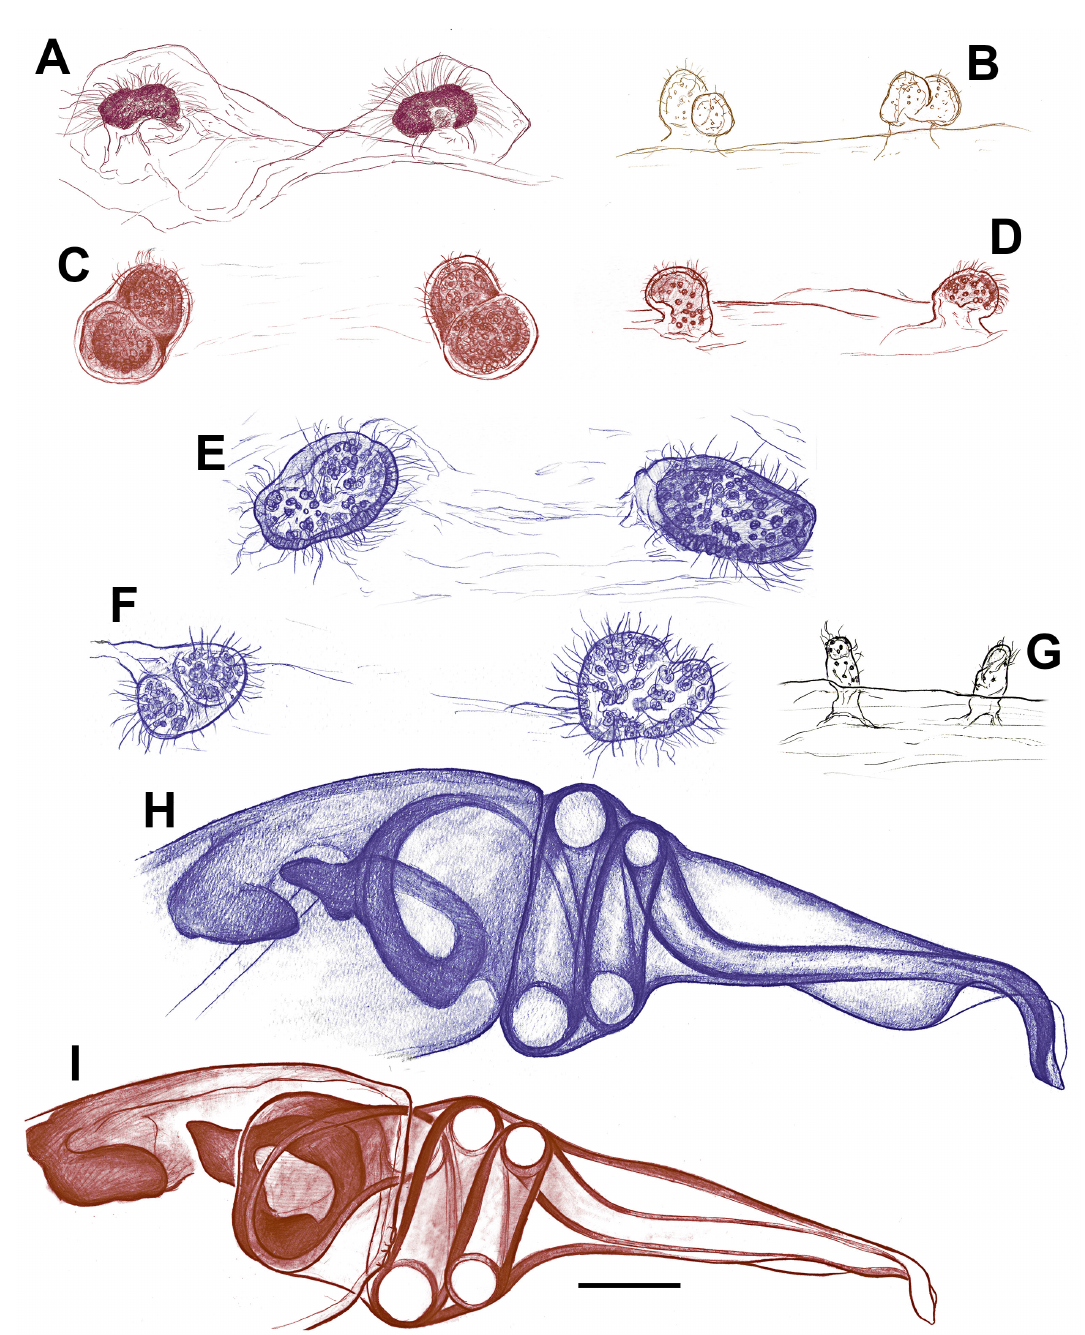
Fig. 3. A–G . Endogynes Filistata Latreille, 1810, ventral view. A . Filistata wunderlichi Zonstein & Marusik, 2019 from Spain, Boca de los Frailes (CRBA IFM-2197). B . Filistata IFMsp191 from Israel, Odem (MACN-Ar 41262). C . Filistata insidiatrix (Forsskål, 1775) from France, Gonfaron (MACN-Ar 39461). D . Filistata insidiatrix from Israel, Beriniki (HUJ-INVAr 21052). E . Filistata betarif sp. nov. from Israel, Oah cave (HUJ-INVAr 21055). F . Filistata betarif sp. nov. from Israel, Tinshemet cave (MACN-Ar 41222). G . Filistata IFMsp99 (subadult ♀?) from Palestine, En Fashkha (HUJ-INVAr 20277). — H–I . ♂♂, left pedipalp, prolateral. H . Filistata betarif sp. nov., holotype from Israel, Tinshemet cave (HUJ -INVAr 21058). I . Filistata insidiatrix from Spain, Mallorca (MACN-Ar 42346). Scale bar = 0.1 mm, all figures to scale. Colours correspond to clades in